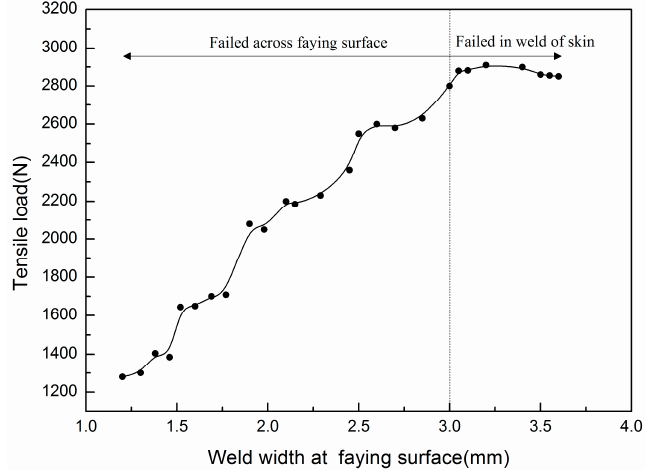
Figure 6. Relationship between weld width at the faying surface ( W ) and tensile shear load.